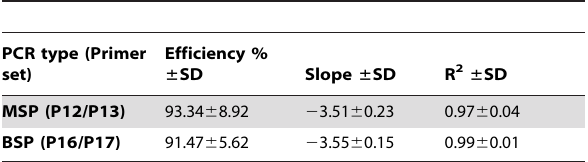
Table 2. Statistical variation of qMSP standard curve. Log Copy Number